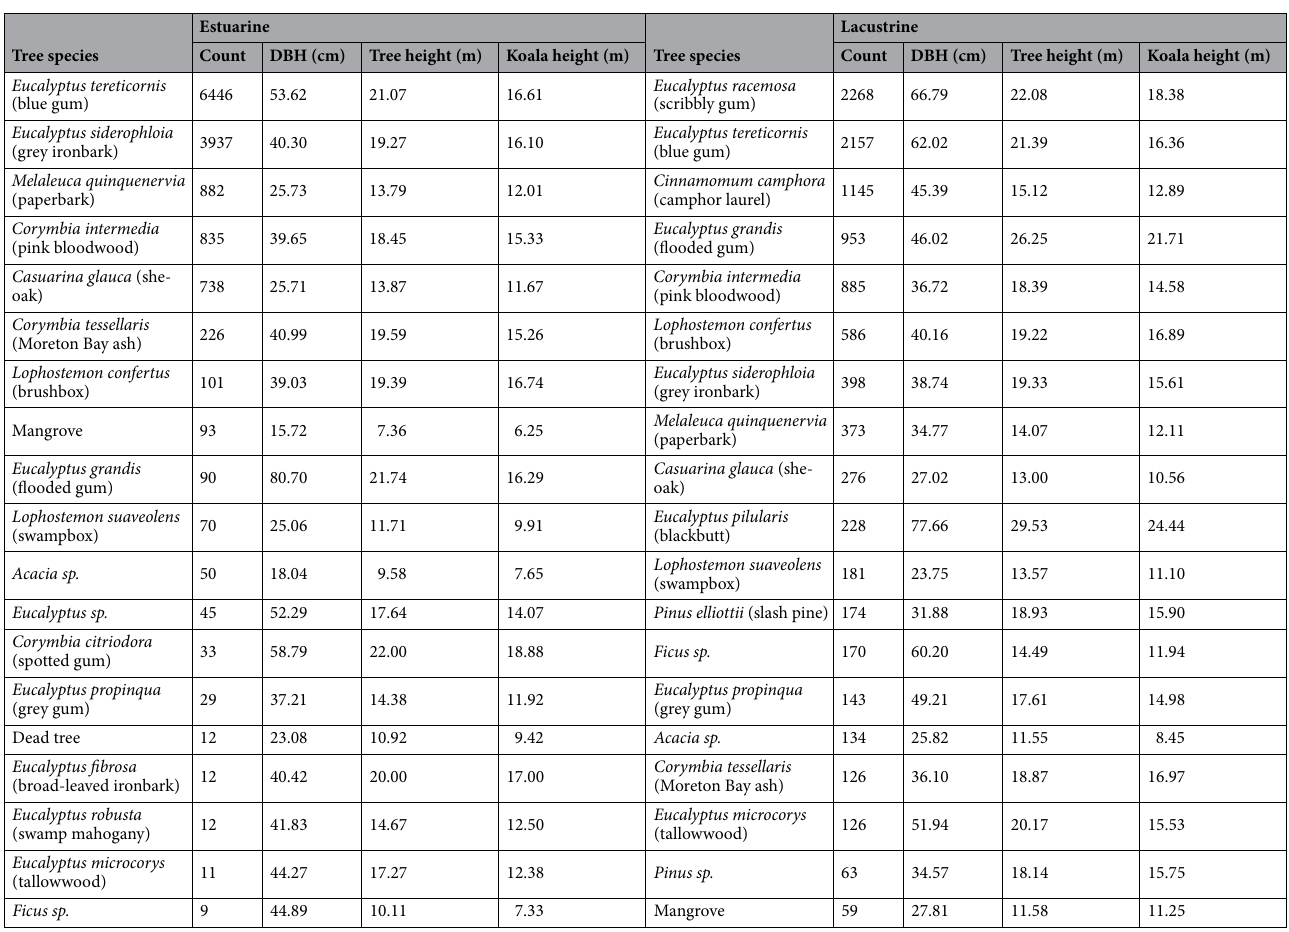
Table 4. Dominant tree species and characteristics of trees in which koalas were located during the study. Count represents the total number of observations (animal relocations) during which a koala was observed on an individual tree species. The data presented for tree diameter at breast height (DBH), tree height, and koala height in trees represents the mean data for all koalas surveyed in each environment. The tree species shown represents > 95% of animal relocations in each environment.